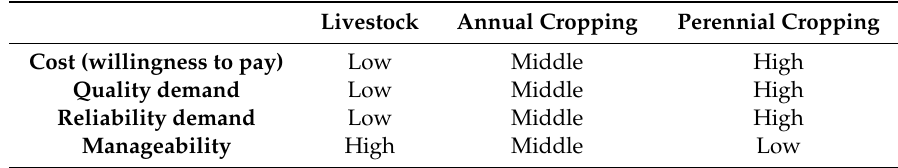
Table 4. Relative di ff erences of demands for water source characteristics as discussed during the interviews, based on farm enterprise